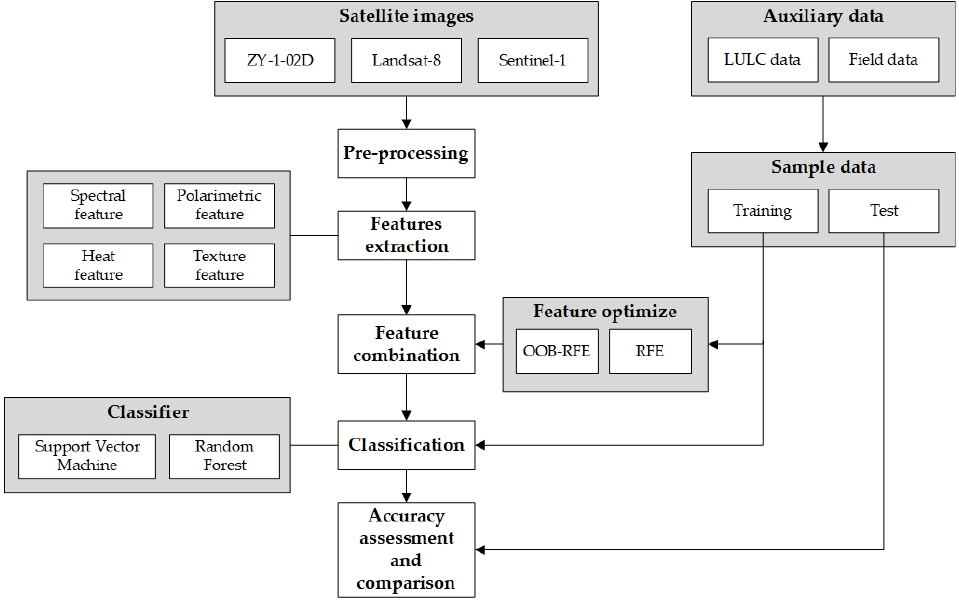
Figure 3. Processing workflow of this study.